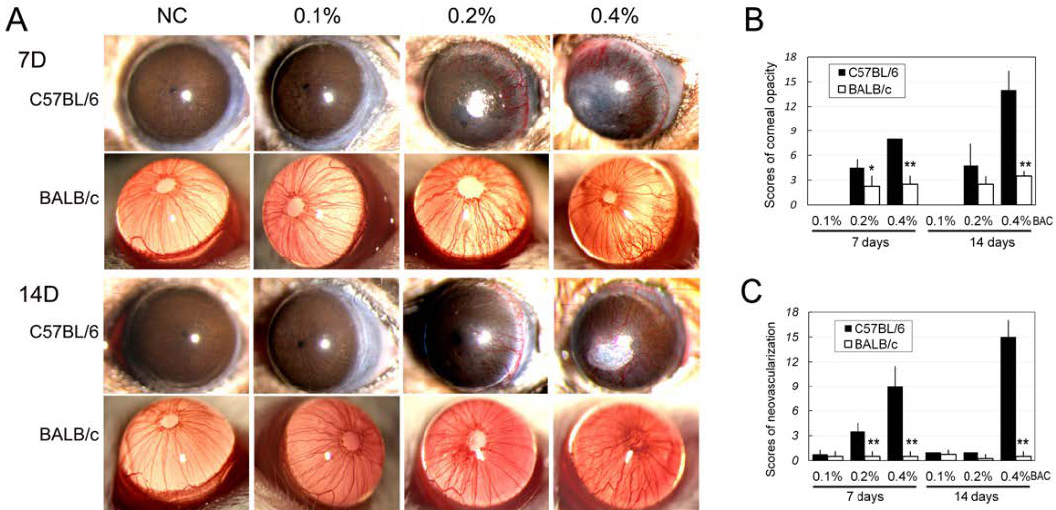
Figure 2. In vivo observations of corneal edema, opacity and neovascularization in mice that received topically applied BAC eye drops. ( A ) Photographs of corneas from C57BL/6 and BALB/mice that were treated with various levels of BAC eye drops for 7 and 14 days. The changes in the corneas were evaluated by scoring: the corneal opacity ( B ); and neovascularization ( C ) following the methods described in the literature (Materials and Methods, n = 10). *: p < 0.05; **: p < 0.01; *, **: C57BL/6 vs. BALB/c. NC: The group received a topical administration of normal saline (NS) as the